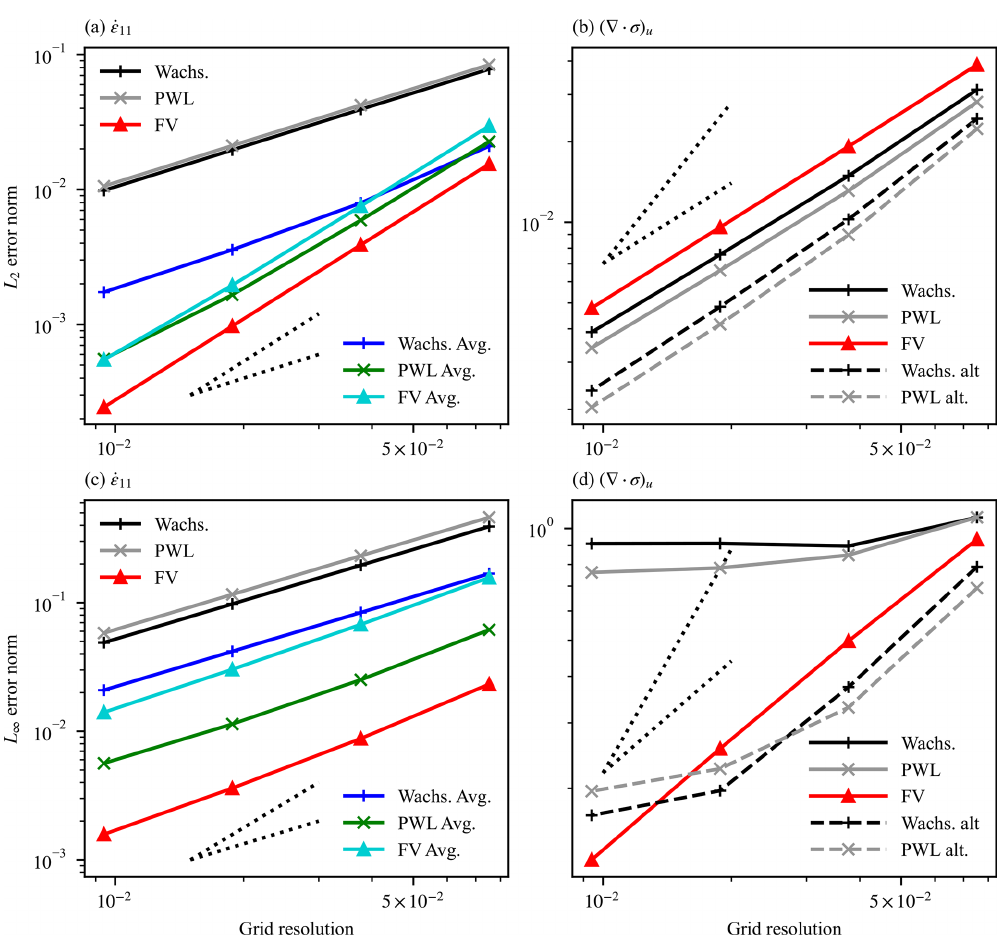
Figure 9. Scaling of L 2 (a, b) and L ∞ (c, d) error norm against grid resolution for the model calculation of (a, c) the ˙ (cid:15) 11 component of the strain rate tensor from an analytical velocity field and (b, d) the u component of the stress divergence from an analytical strain rate tensor field on the unit sphere for a spherical test case. Grid resolution is the mean distance between cell centers. Only mesh cells where θ > 20 ◦ are included. Ideal first- and second-order scaling gradients are also shown as dotted